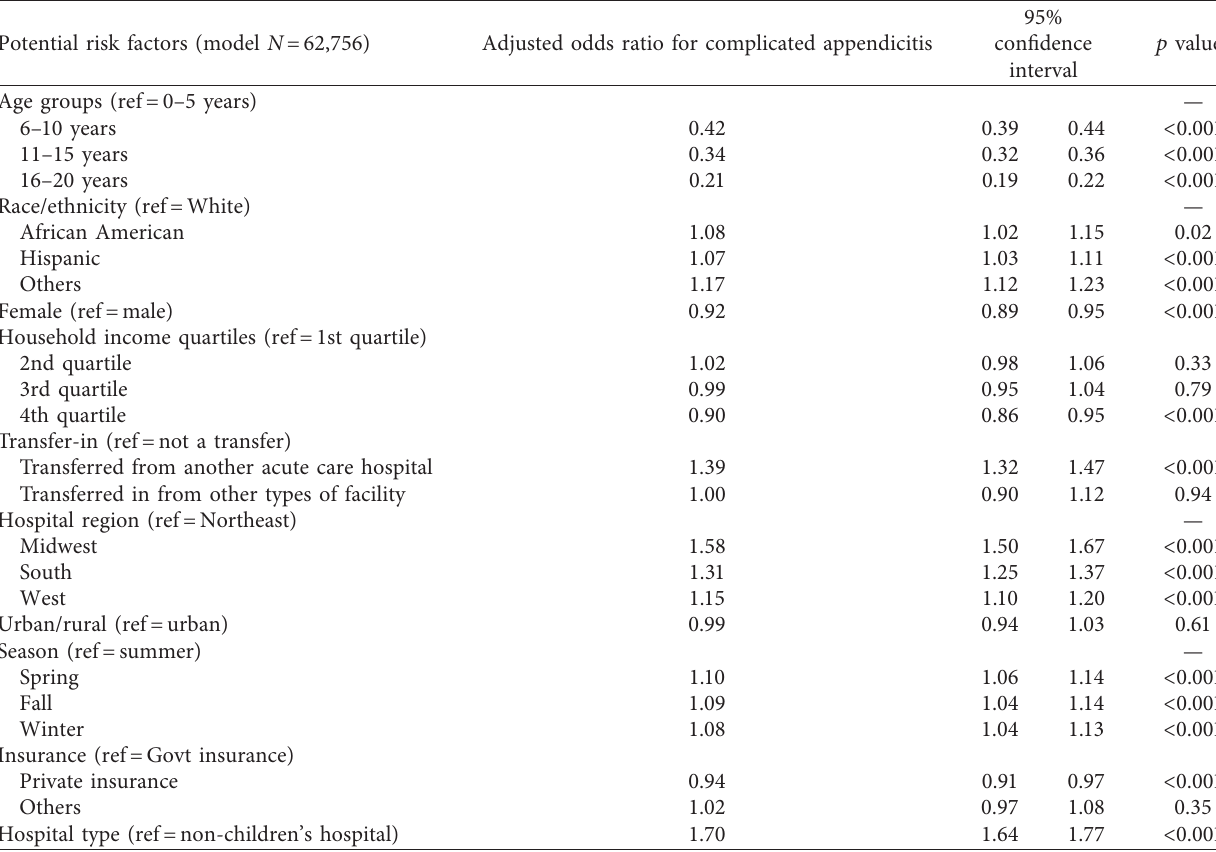
Table 3: Multivariable analysis of risk factors for complicated